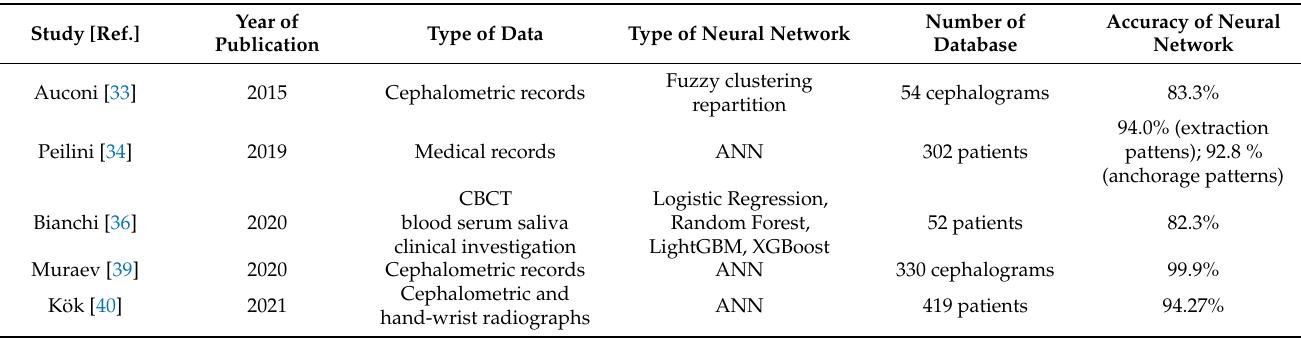
Table 3. Baseline characteristics of the studies included in the review by studying neural networks in